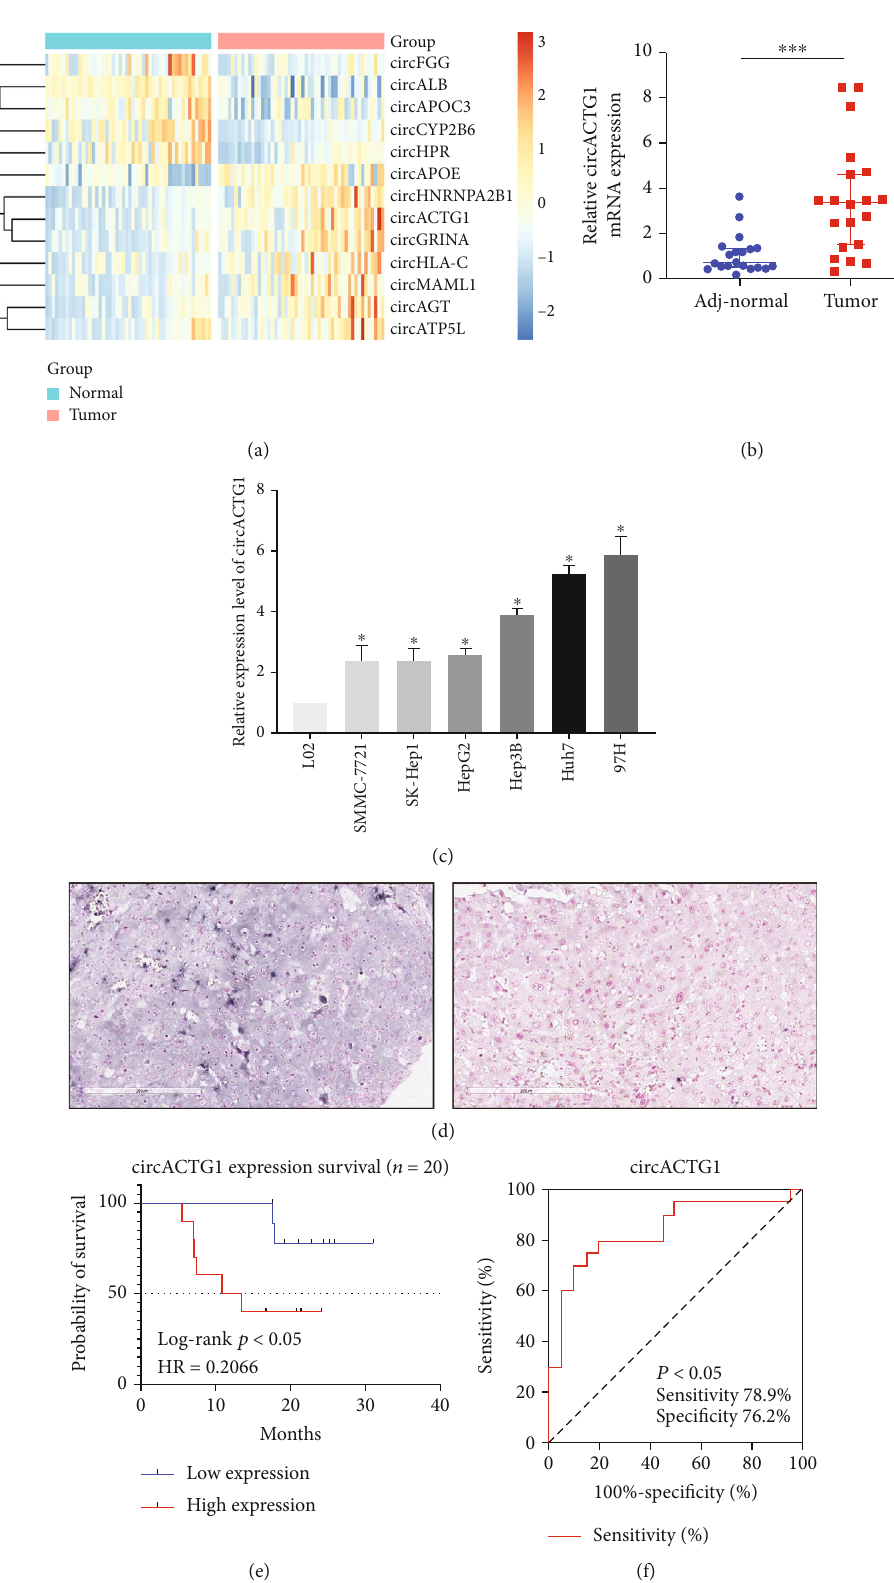
Figure 1: Overexpressed circACTG1 in HCC primary tissues and cell lines showed a collection to worse prognosis. (a) Di ff erent expression of circRNAs in normal and tumor group. (b) circACTG1 mRNA expression level in adjacent normal (adj-normal) and tumor tissues. (c) circACTG1 mRNA expression level in cell lines. (d) In situ hybridization (ISH) by digoxin biotin antibody in adjacent normal tissues and tumor tissues. (e) Overall survival (OS) time curve of 20 patients. (f) Receiver operating characteristic (ROC) curve analysis of